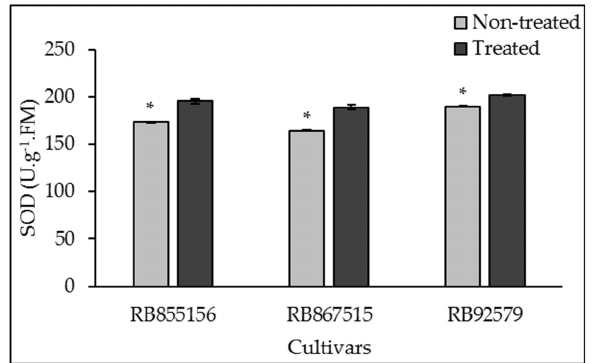
Figure 3. Activity of the superoxide dismutase (SOD) enzyme in sugarcane plants treated with pyraclostrobin in relation to control plants. The results represent the average of six evaluation times and three replications. * Indicates a significant difference among treatments by the Tukey test at 5% probability. The bar indicates the standard error of the mean. FM: Fresh matter; U: SOD unit.